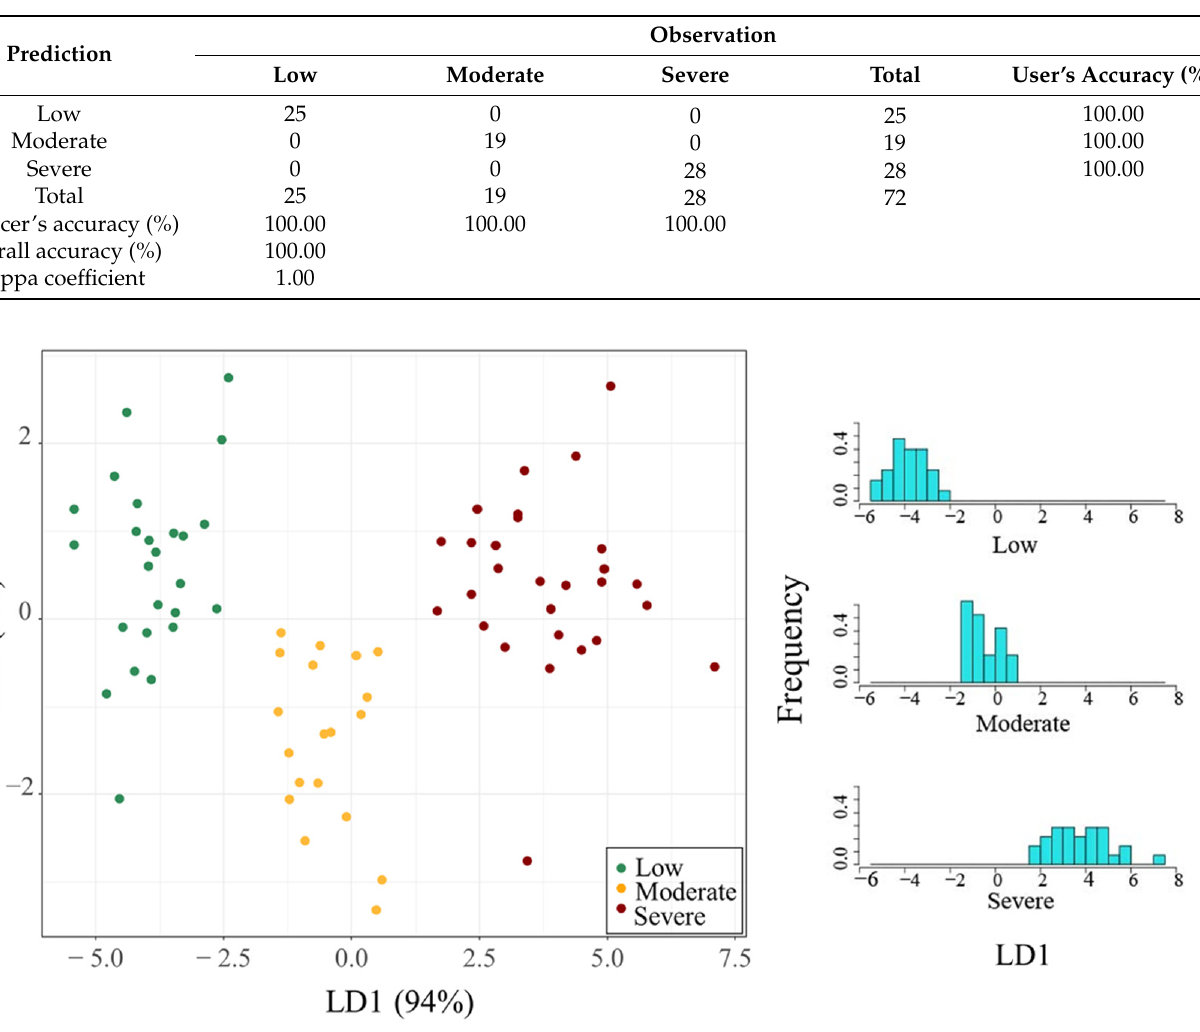
Table 2. Confusion matrix of Sentinel-2-based spectral classification of erosion intensity using a combination of principal component and linear discriminant analysis (PCA-LDA).